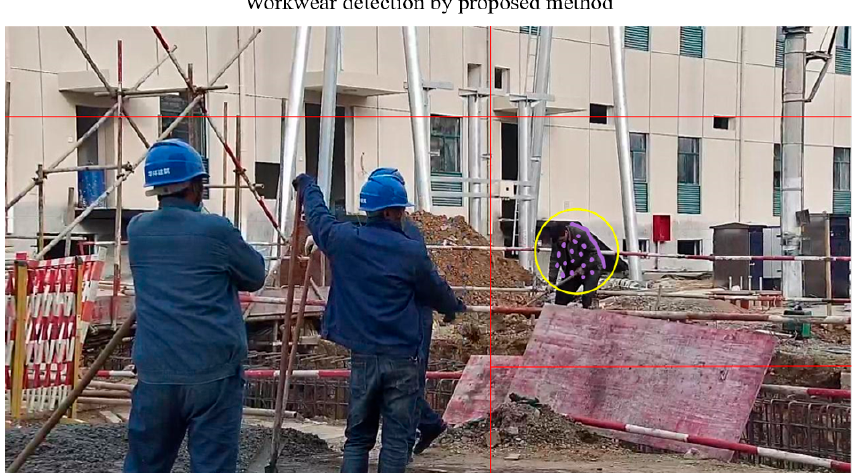
Electronics 2023 , 12 , 1933